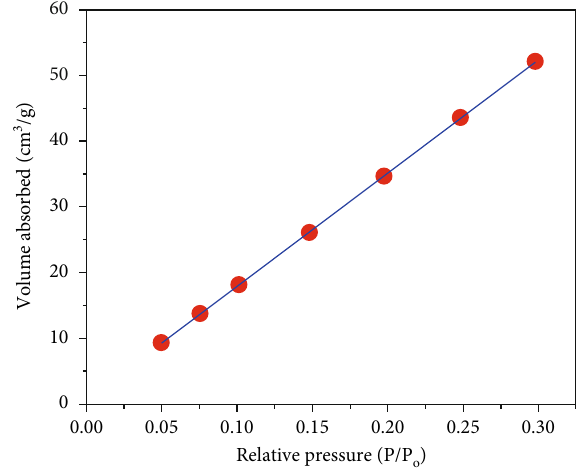
Figure 6: Nitrogen adsorption-desorption isotherms of CeO Fe O mixed oxide with the CF molar ratio of 1 :1 calcined at 2 3 650 ° C for 2 h.